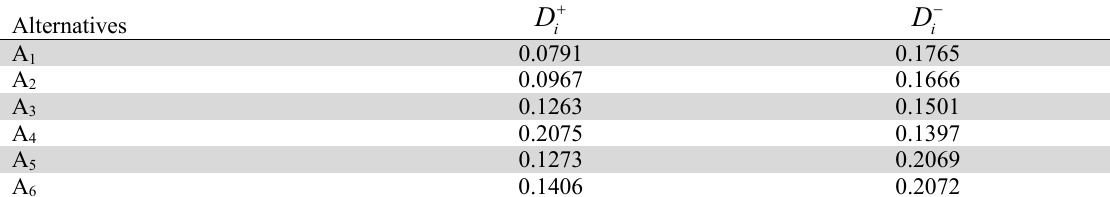
Total ideal and not-ideal distance for the economic criteria Alternatives